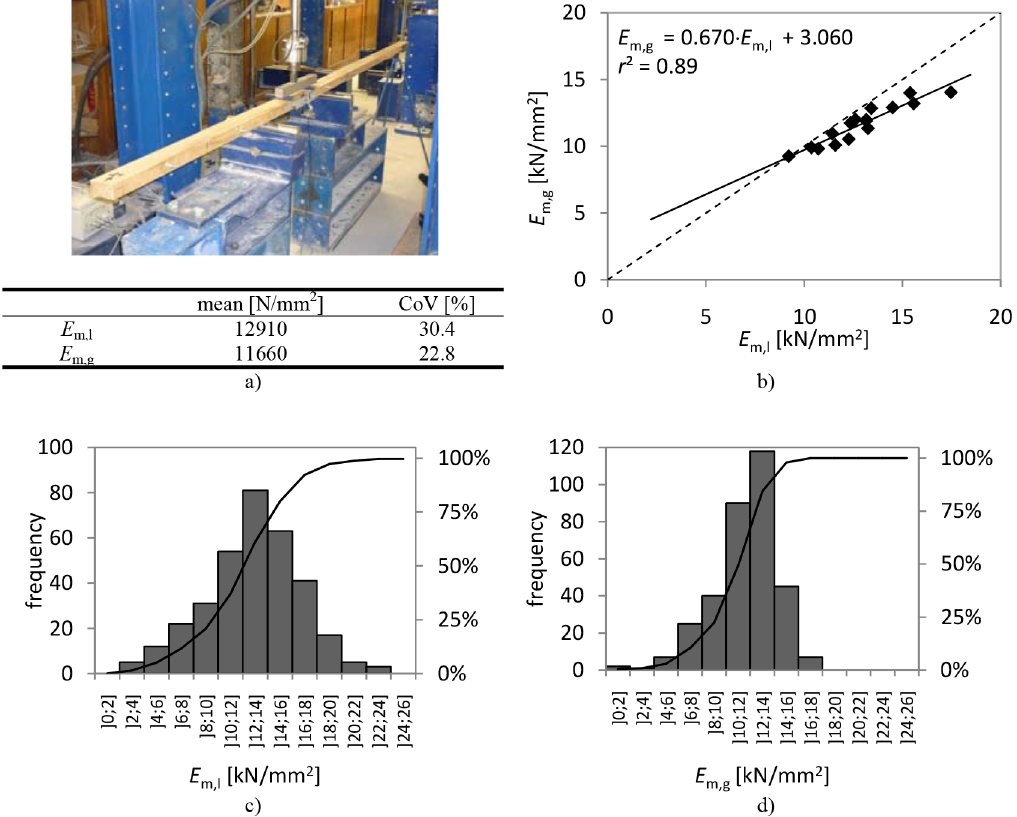
Fig. 8. Sawn boards bending tests in elastic regime: a) test set-up and results; b) correlation between E m,l and E m,g ; c) histogram and cumulative distribution function for E m,l ; d) histogram and cumulative distribution function for E